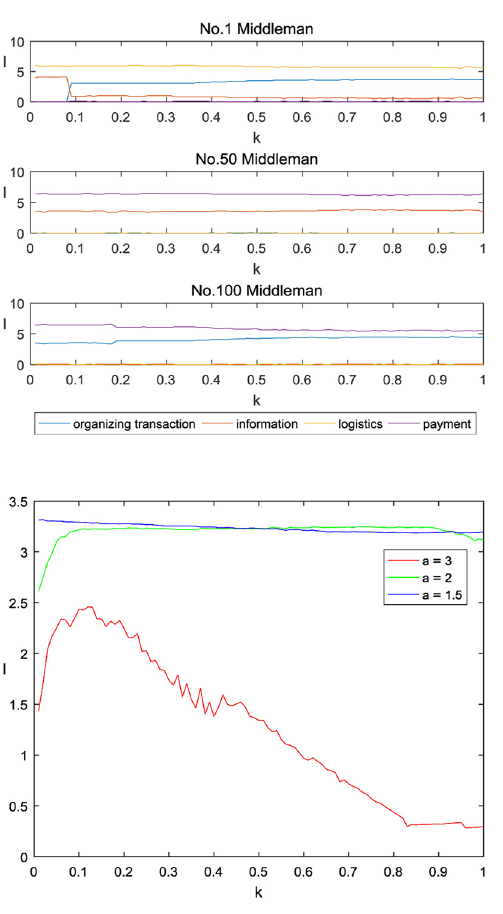
Figure 5. Uncorrected sample standard